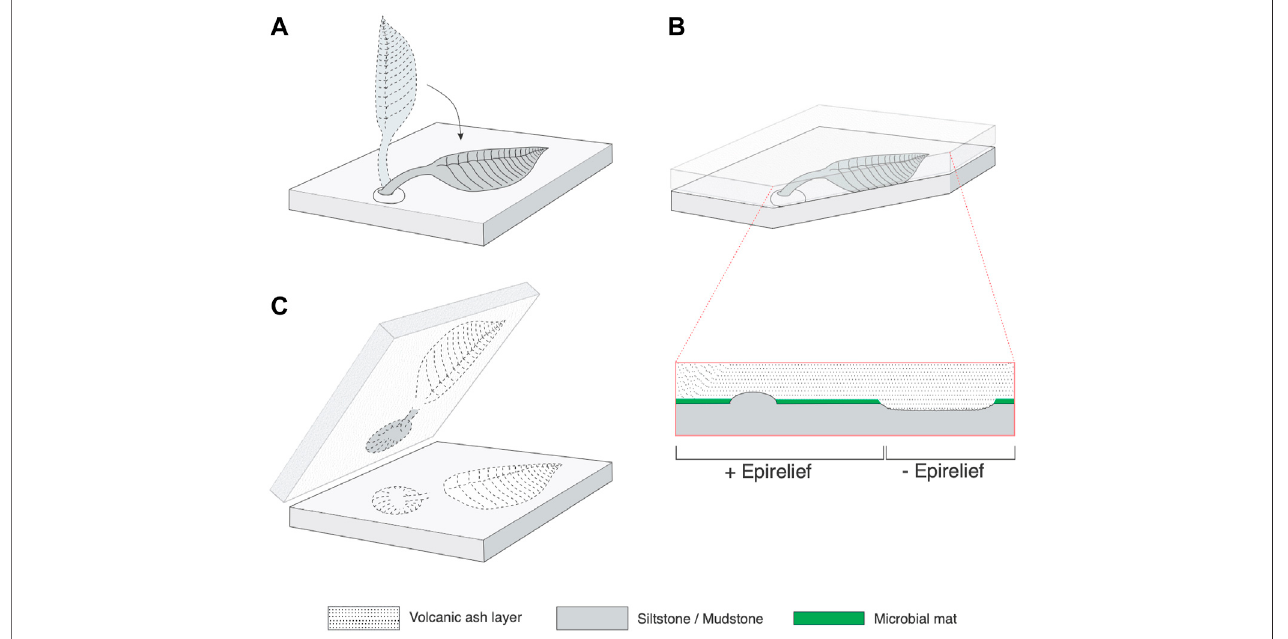
FIGURE 4 | Preservation style observed in Ediacaran organisms in Avalonia. (A) : Felling of an undetermined erect stemmed frond. (B) : Transversal cut of the felled frond preserved between the underlying volcaniclastic siltstone and the overlying tuf fi te; close-up shows features preserved in positive and negative reliefs and smothered matground. (C) : Resulting reliefs in the underlying volcaniclastic siltstone and their counterparts in the tuffaceous layer.